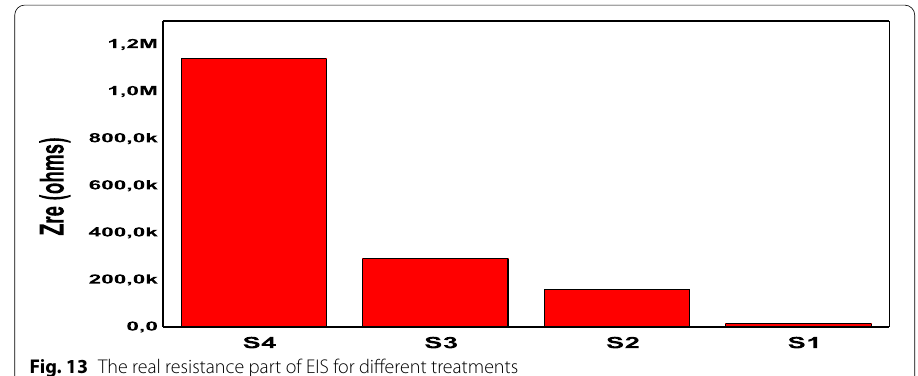
Fig. 13 The real resistance part of EIS for different treatments